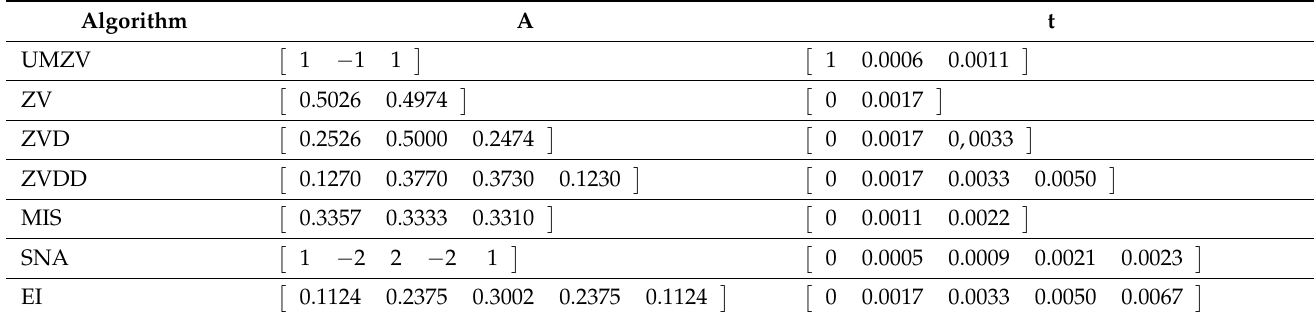
Table 4. Parameters of ISC techniques.